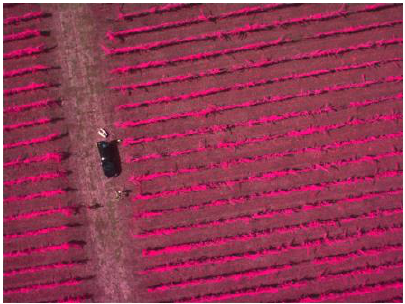
Figure 20.Ortophoto from multispectral image Sept. 2 nd 2017